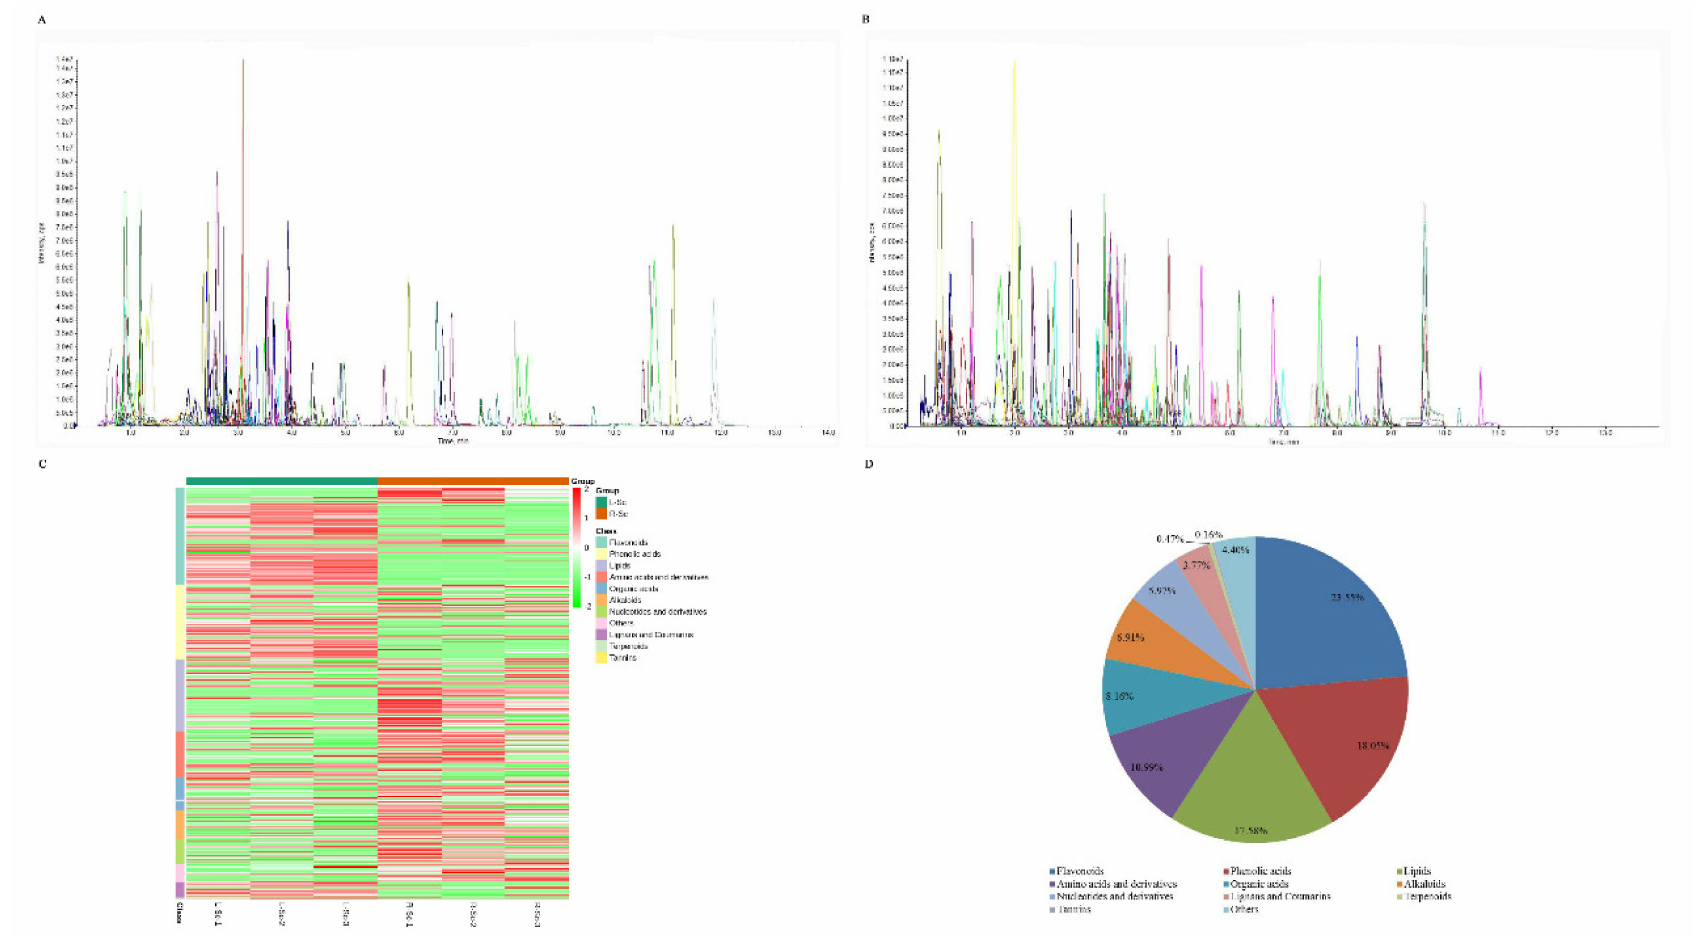
Figure 2. Qualitative and semi-quantitative analysis of metabolites in S. collina . Multipeak mass spectral chromatogram of metabolites acquired in negative ion mode ( A ) and positive ion mode ( B ). ( C ) Heatmap of the metabolites in the shoots and roots of S. collina (L-Sc and R-Sc, respectively). ( D ) Types and proportions of the identified metabolites from the L-Sc and the